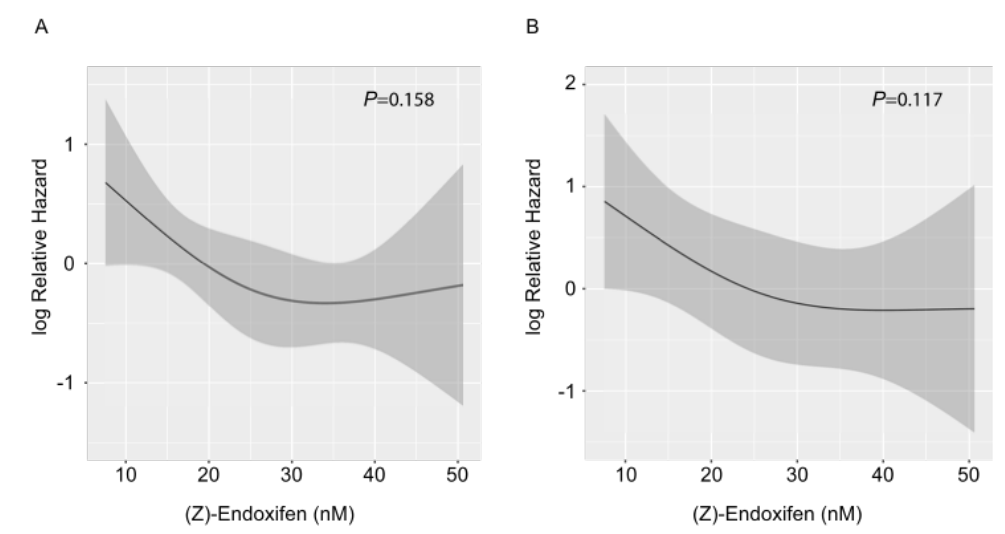
Figure 1. Kaplan – Meier curves of (Z)-endoxifen stratified by a putative threshold of 15 nM. The hazard ratio and 95% confidence intervals for below versus above threshold are given in brackets.